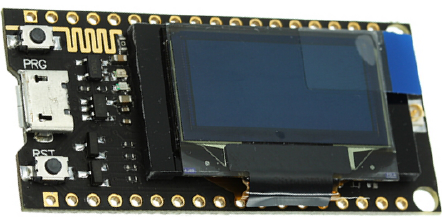
Figure 4. ESP-32 TTGO developer